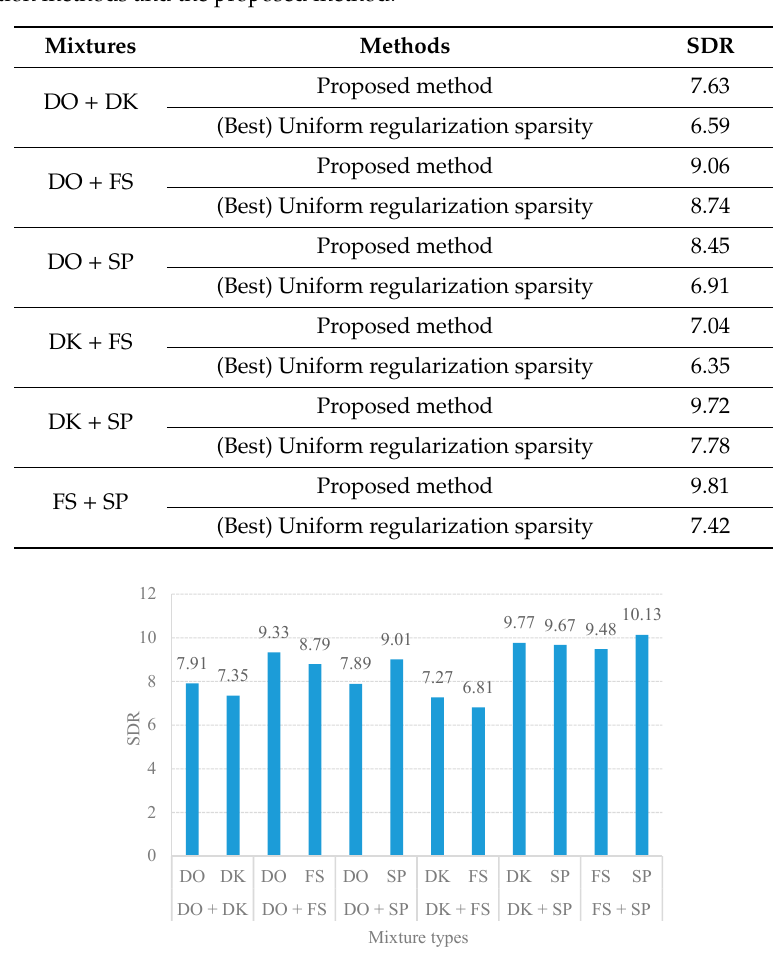
Table 1. Comparison of average SDR performance on three types of mixtures between uniform regularization methods and the proposed method.